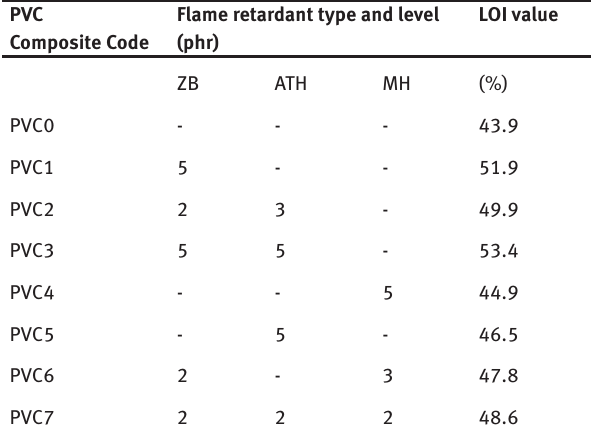
Table 1: Limiting Oxygen Index test results of PVC composites.